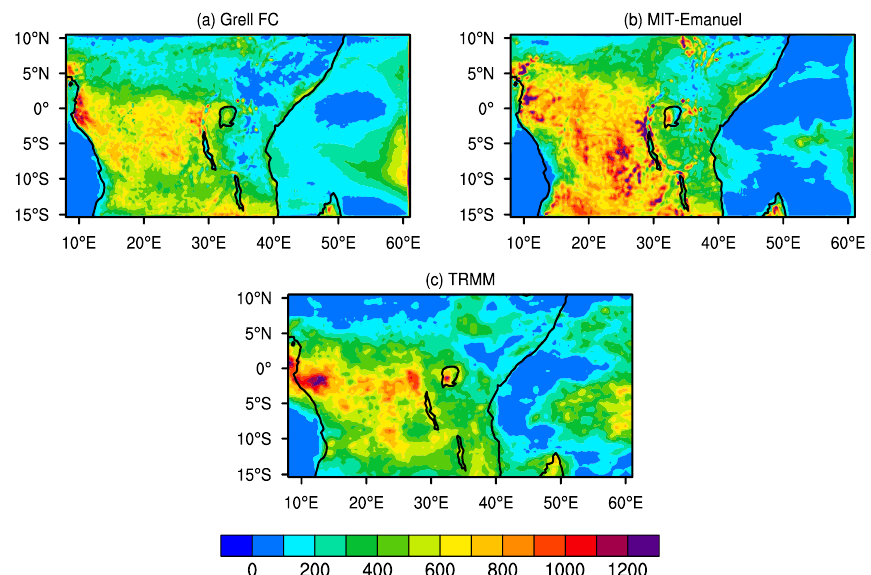
Figure 4. Precipitation (mm) distribution using the Nogherotto–Tompkins microphysics scheme for ( a ) Grell FC and ( b ) MIT-Emanuel, and ( c ) TRMM during the Short Rains in 2000. Table 2. Summary of evaluation statistics for Regional Climate Model (RegCM) simulations done to test the performance of the different microphysics scheme for precipitation. RMSE is the root mean square error, SD Mod.—standard deviation calculated from model output and SD Obs.—standard deviation for observations, Cor is the pattern correlation coefficient. Scheme Region RMSE SD